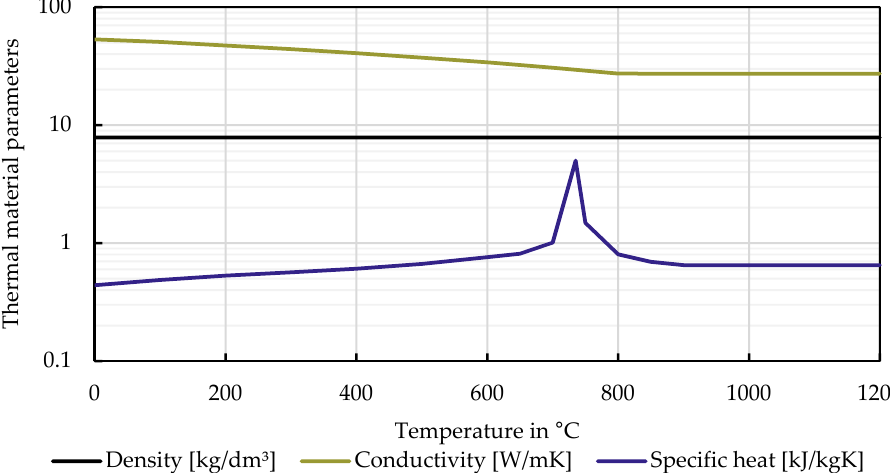
Figure 2. Calculated values of the temperature-dependent thermal material properties of concrete (reproduced from [8]).